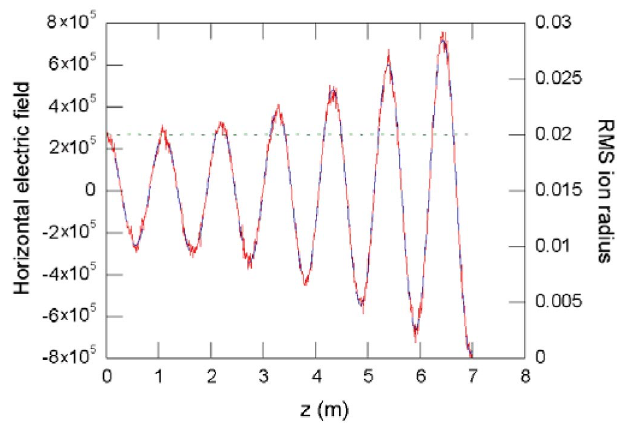
FIG. 12. (Color) Comparison of the electron centroid grid and analytic electric fields, using method 2. The solid red line shows the electric field calculated on the simulation grid, the dashed blue line shows the electric field calculated by the analytic model, and the dashed green line shows the rms ion size.